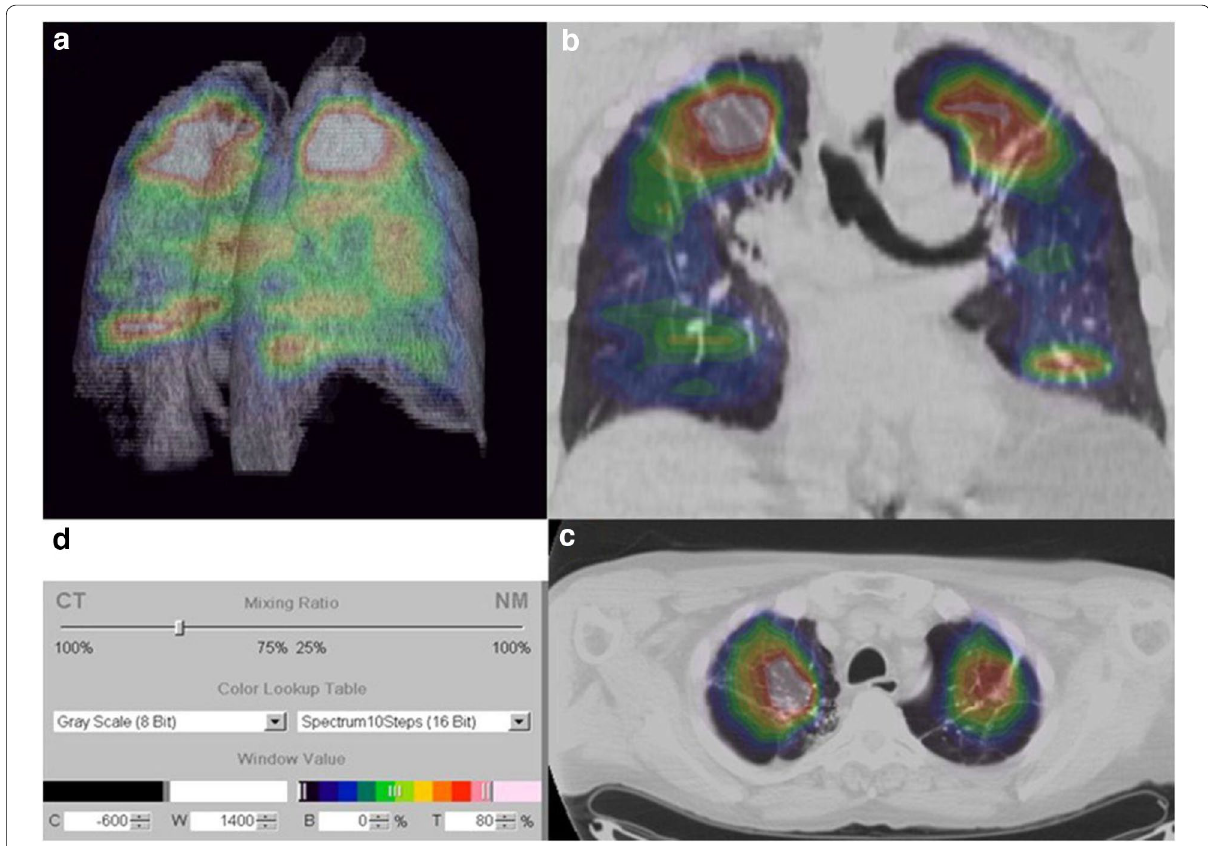
Fig. 3 a Three-dimensional, b axial, and c coronal imaging illustrating the predominantly apical distribution of pulmonary 18 fluorodeoxyglucose ([ 18 F]-FDG) uptake in a patient with usual chronic obstructive pulmonary disease (COPD). d The color scale gives the spectrum applied to the full range of [ 18 F]-FDG uptake, so that each color band represents a range of 10% of the maximum signal, with the maximum signal represented by white and the minimum signal by black . (Reprinted from [28] with permission of the American Thoracic Society. Copyright © 2017 American Thoracic